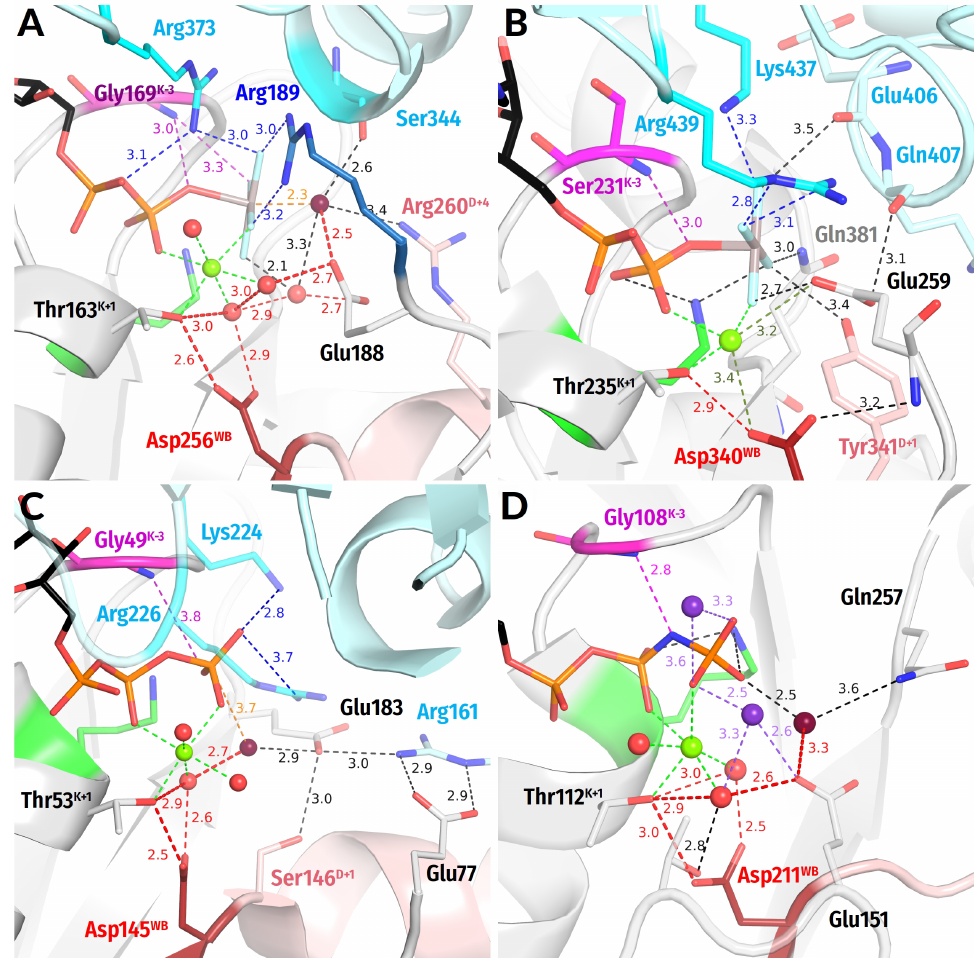
Figure 6. Representative proteins of the RecA/F 1 -like class of the P-loop NTPases. The Arg finger as provided by the P-loop domain proper is shown in deep blue (panel ( A )); K + ions are shown as purple spheres (panel ( D )). Red dashed lines mark protonic connections between W cat and Asp WB . Other colours as in Figures 1E,F and 3. All distances are in ångströms. ( A ) Bovine F 1 -ATPase (PDB ID 1H8E, [43]). ( B ) DnaB replicative helicase from Vibrio cholerae (PDB 6T66 [129]). ( C ) Circadian clock protein KaiC (PDB ID 4TL7, [123]). ( D ) RadA recombinase (PDB ID 3EW9,